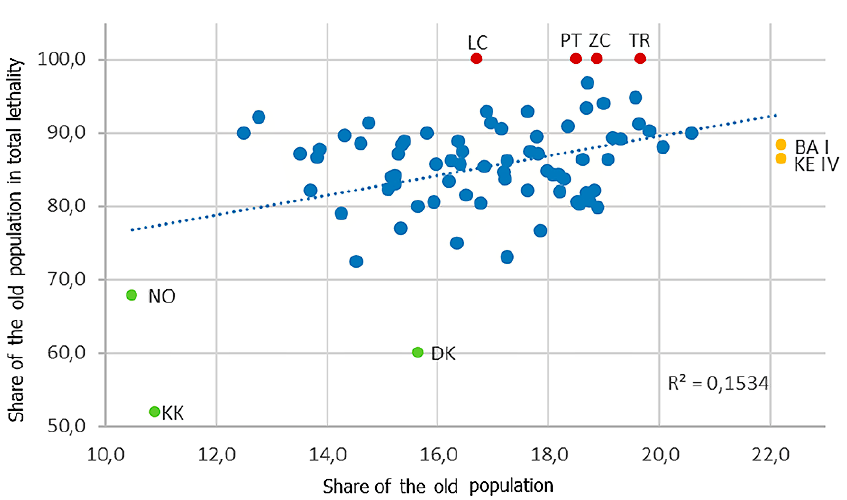
Figure 10. Share of the old population (65 and over) and lethality of Covid-19 in districts of Slovakia in